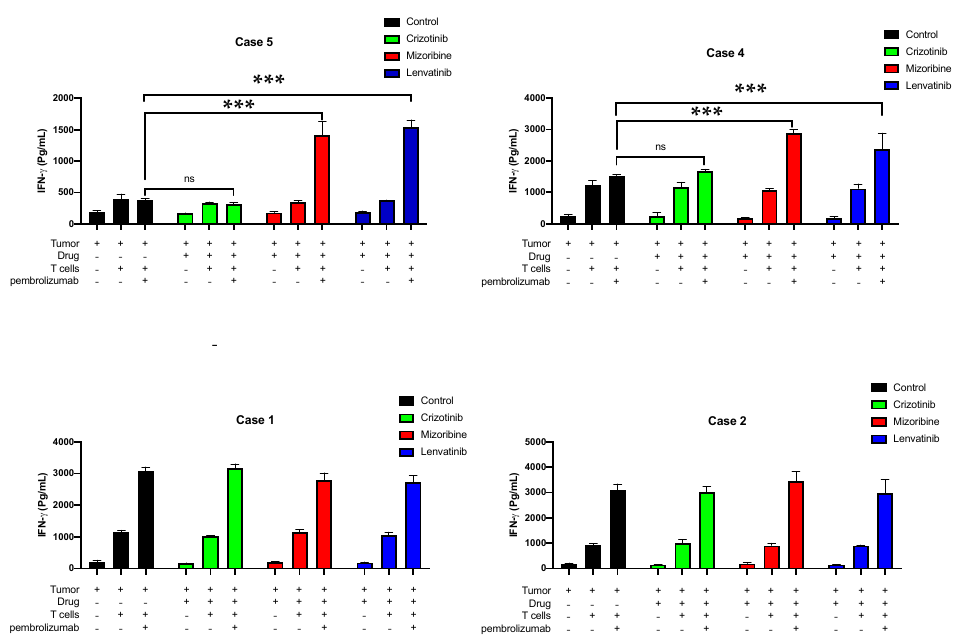
Figure 6. In vitro treatment with anti-PD-1 with or without lenvatinib for CD8+ T cells of patients 1, 2, 4, and 5. All four patients were tested in vitro for 12 different conditions in triplicates. This figure shows the IFN- γ values in pg units upon 12 different conditions. mizoribine (red) and crizotinib (green) were used as positive and negative controls, respectively; the control (black) was untreated, and lenvatinib (blue) was the experimental test. A549 cells were first seeded on 96-well plates 24 h before adding the drugs. Then, drugs were added, and cells were incubated for 10 h. Media with or without anti-PD-1 antibody (pembrolizumab) containing the T cells of different patients was added after performing three PBSX1 washes for the whole 96-well plate. Human IFN- γ was performed using the collected media from the experimental wells and measured using the enzyme-linked immunosorbent assay (ELISA) method at a wavelength of 650 nm. A two-way analysis of variance (ANOVA) multiple comparisons test was performed among the groups for each patient individually, with three biologically independent counts in each group. *** p < 0.0001 for both the mizoribine- and the lenvatinib-treated groups in patients 4 and 5. All statistical data analysis was performed using GraphPad Prism, version